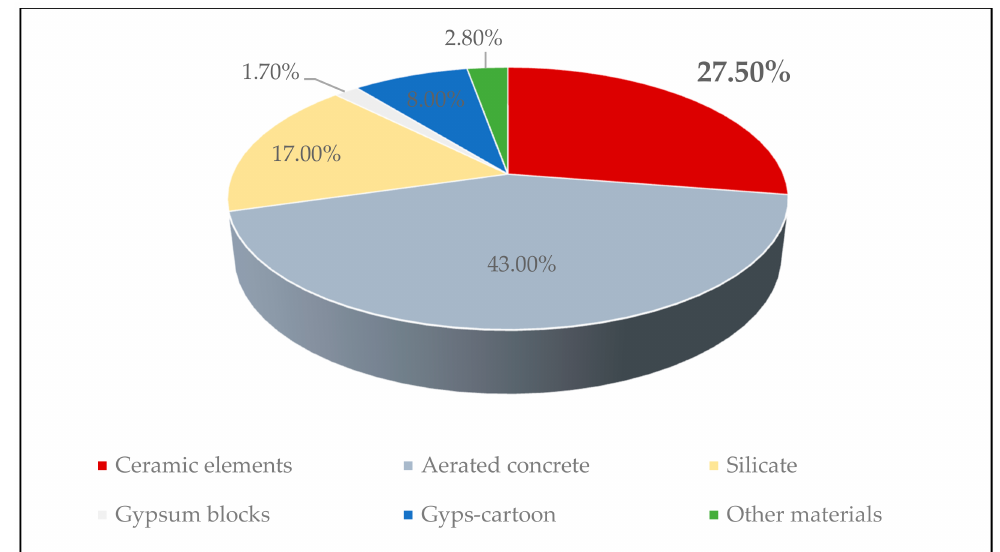
Figure 1. Distribution of the use of wall materials for the construction of non-load-bearing walls in residential buildings in Poland in